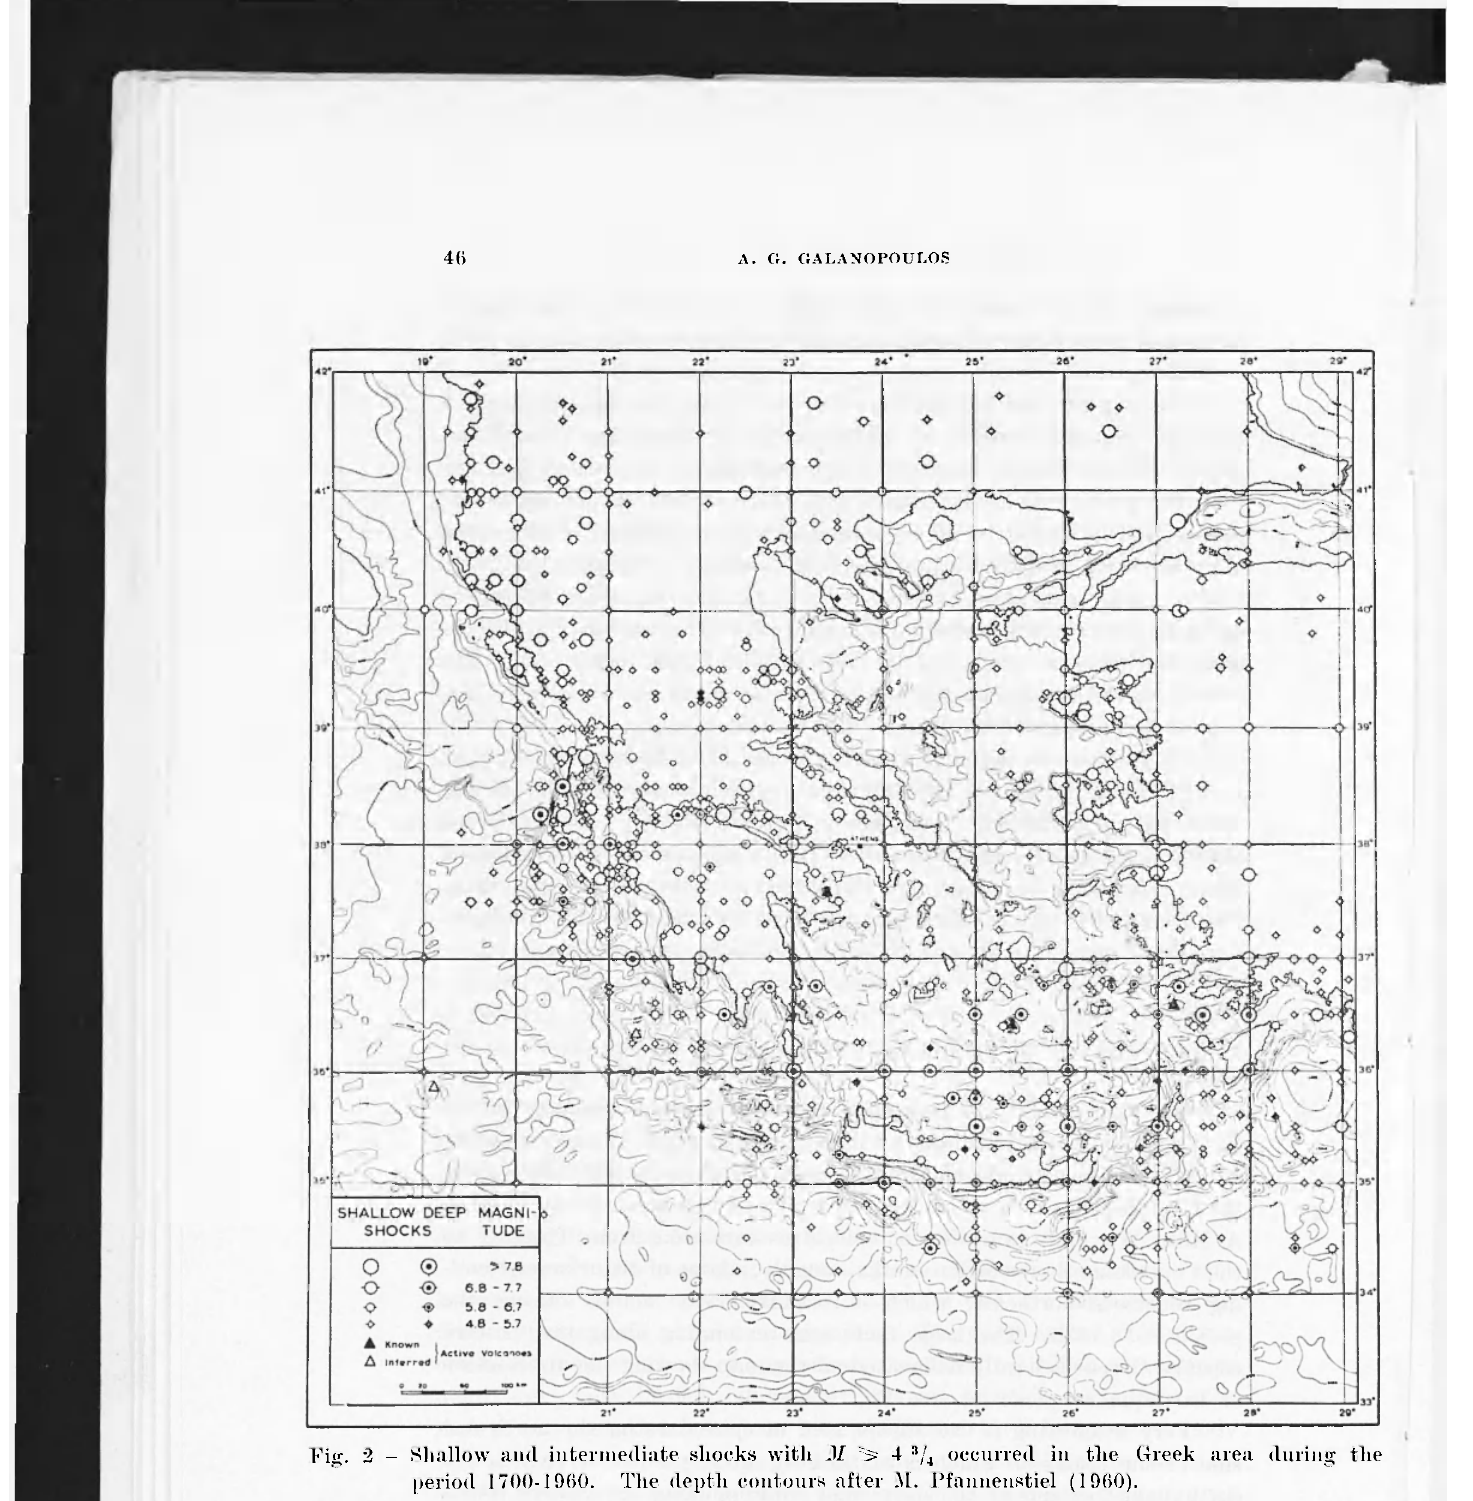
Fig. 2 - Shallow and intermediate sliocks with 4 3 / 4 oecurred in the Greek area during the period 1700-1960. The depth contours after M. Pfannenstiel